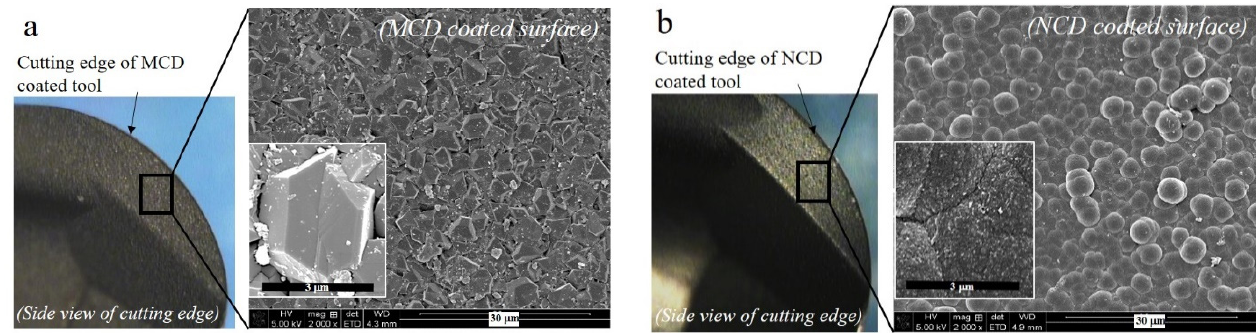
Figure 3. Morphology of ( a ) MCD and ( b ) NCD coatings.